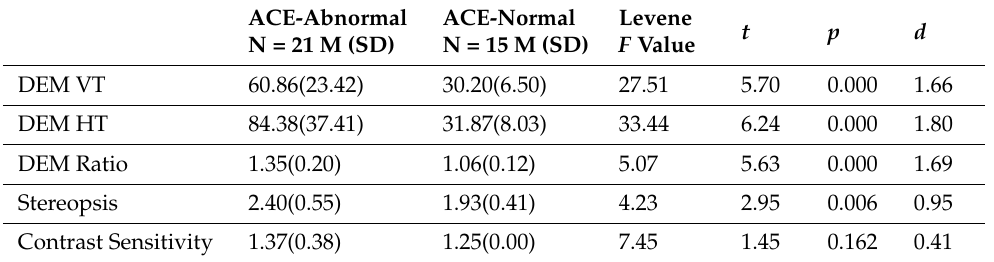
DEM: developmental eye movement; VT vertical time; HT: horizontal